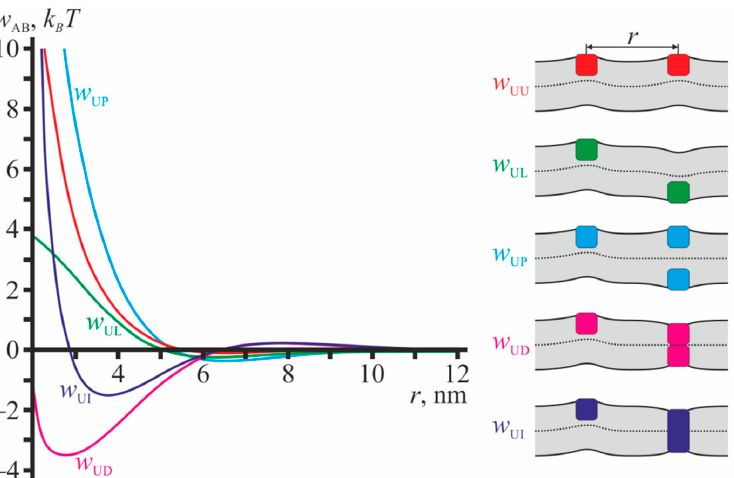
Figure 2. Profiles of pairwise interaction potentials for configurations involving gA monomers. Red curve— w UU ( r ); green curve— w UL ( r ); blue curve— w UP ( r ); magenta curve— w UD ( r ); dark blue curve— w UI ( r ) (for transmembrane inclusion). The configurations are schematically illustrated in the right-hand-side of the figure. The membrane is shown as light gray stripe; solid black lines correspond to surfaces of the upper and lower monolayers; dotted line corresponds to the monolayer interface; gA monomers are shown as squares; the transmembrane inclusion is shown as the rectangle. The colors of the particles in the right-hand-side of the figure correspond to the colors of the interaction potential curves w AB .